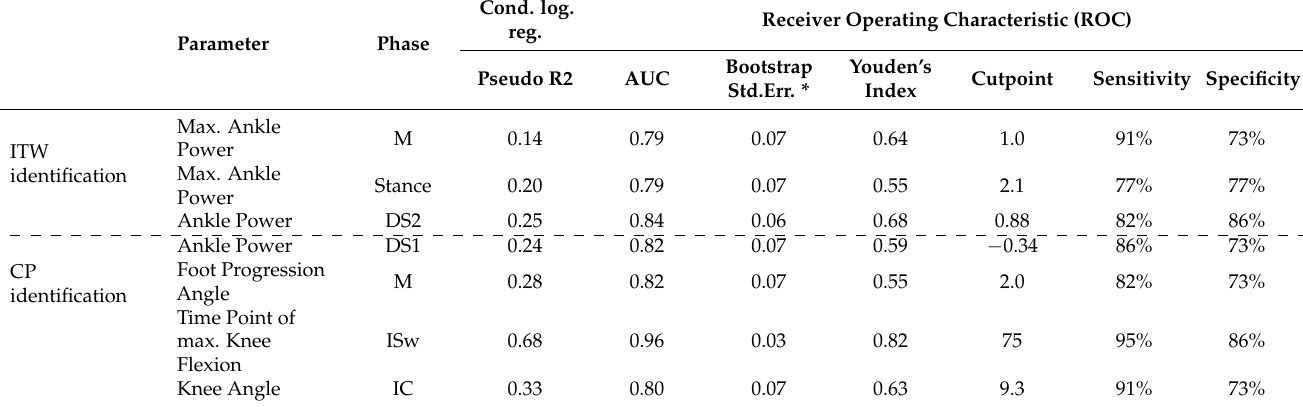
Table 3. Receiver operating